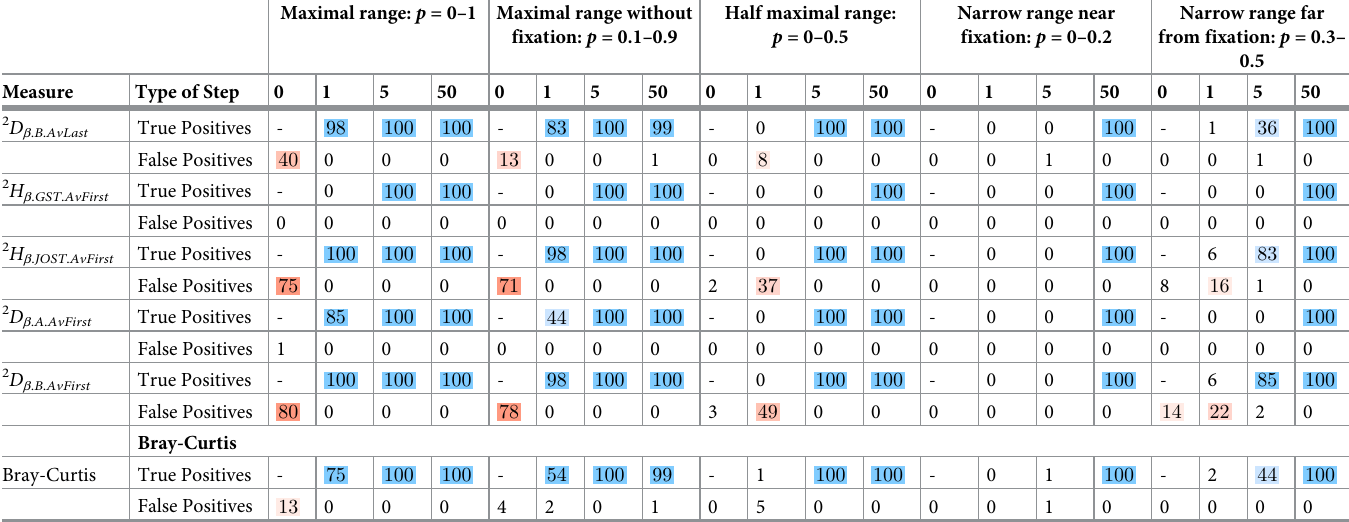
Narrow range near fixation: p = 0–0.2